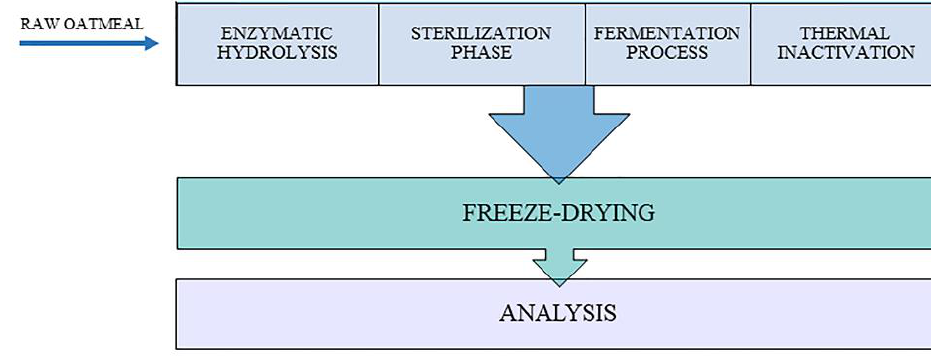
Figure 1. Flow diagram of the experimental design.